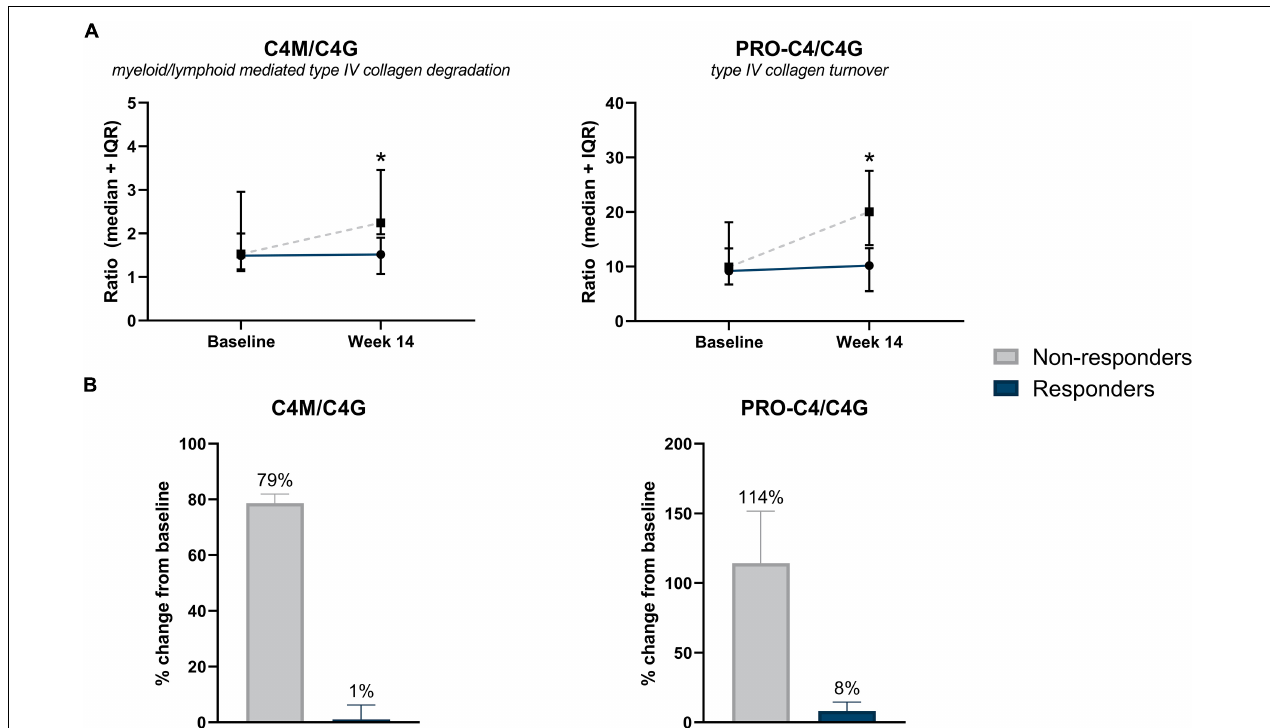
FIGURE 3 | (A) Serum biomarker levels in CD patients without surgical history, stratified by response to IFX treatment. Serum levels of type IV collagen ratios C4M/C4G and PRO-C4/C4G were elevated in non-responders at week 14 compared with responders ( P = 0.035, P = 0.020). Significance was calculated using Mann–Whitney U -test. Data are shown as median + IQR. (B) Percent change from baseline of type IV collagen turnover between responders and non-responders, within CD patients with no history of prior surgery. Non-responders showed a 79 and 114% increase from baseline of type IV collagen turnover ratios C4M/C4G and PRO-C4/C4G, respectively. * P <